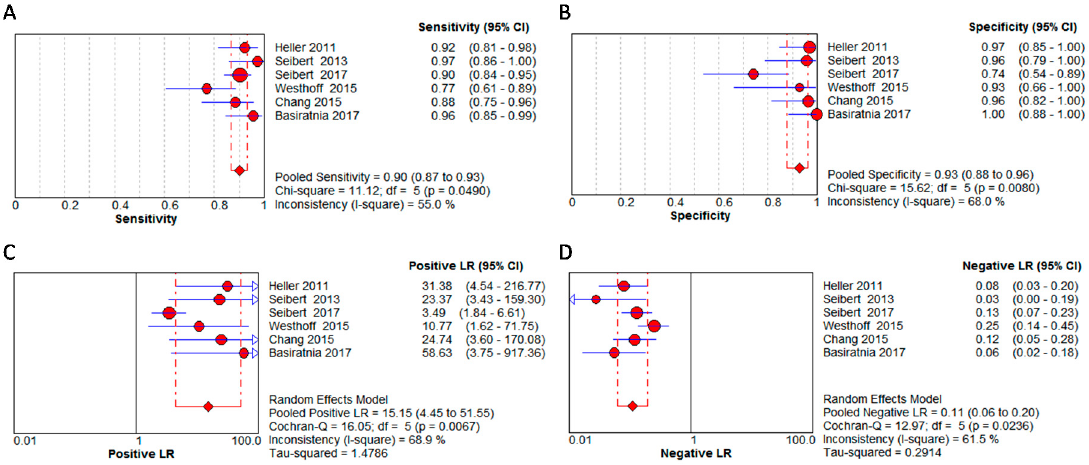
Figure 3. Diagnostic performance of urinary calprotectin on discriminating between intrinsic acute kidney injuries and prerenal acute kidney injury.